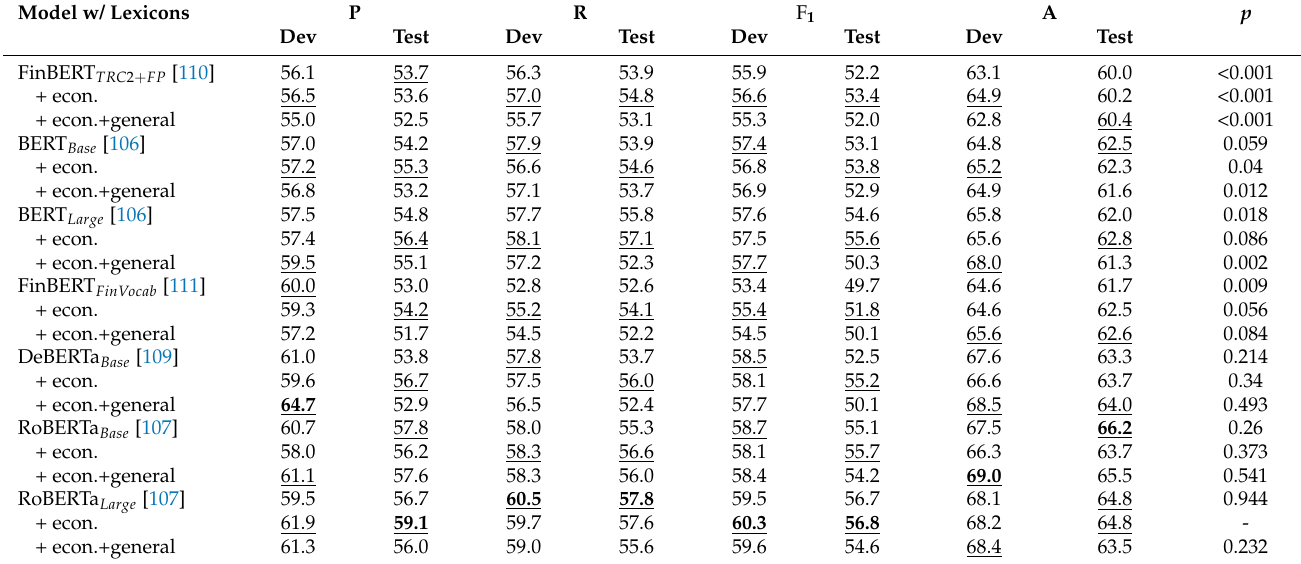
Table 8. Clause-based implicit sentiment results on the development set and holdout test set for winning models after optimizing the hyperparameters for each architecture. Precision (P), recall (R), and F 1 -score (F 1 ) percentages are macro- averaged. Accuracy (A) is reported with the p -value of McNemar’s significance test of predictions with respect to the best model (RoBERTa Large + econ.). Boldface type indicates highest score overall and underlining indicates the highest score within encoder